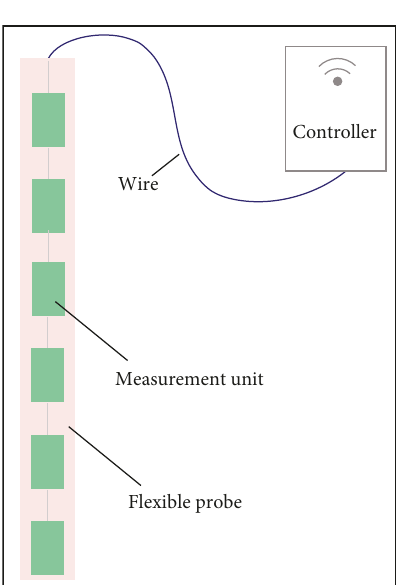
Figure 6: Components of the deep displacement measurement